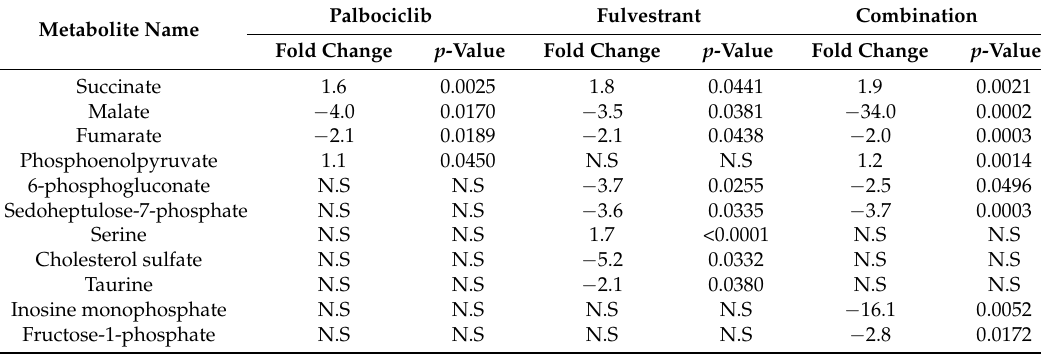
Table 1. Panel of significantly altered metabolites 2 days after dosing with palbociclib ( n = 4), fulvestrant ( n = 4) or a combination dose of both palbociclib and fulvestrant ( n = 4) when comparing dosed groups to control. Values are log transformed fold changes after quantification by multiple reaction monitoring, unpaired two-tailed t